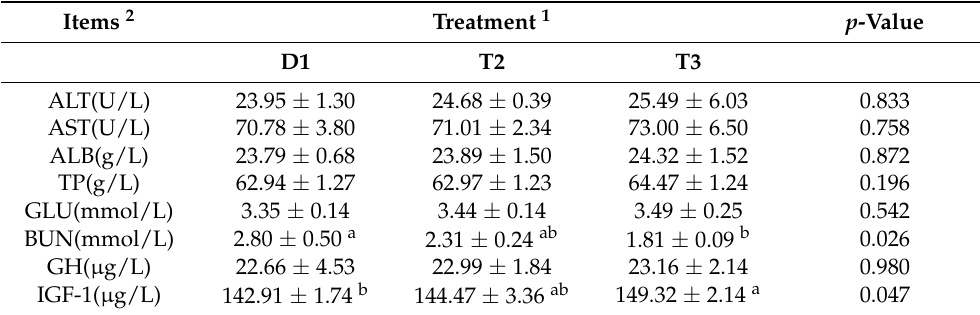
Table 5. Effects of low-protein dietary inclusion of RPLys and RPMet on blood biochemistry of Holstein bulls.